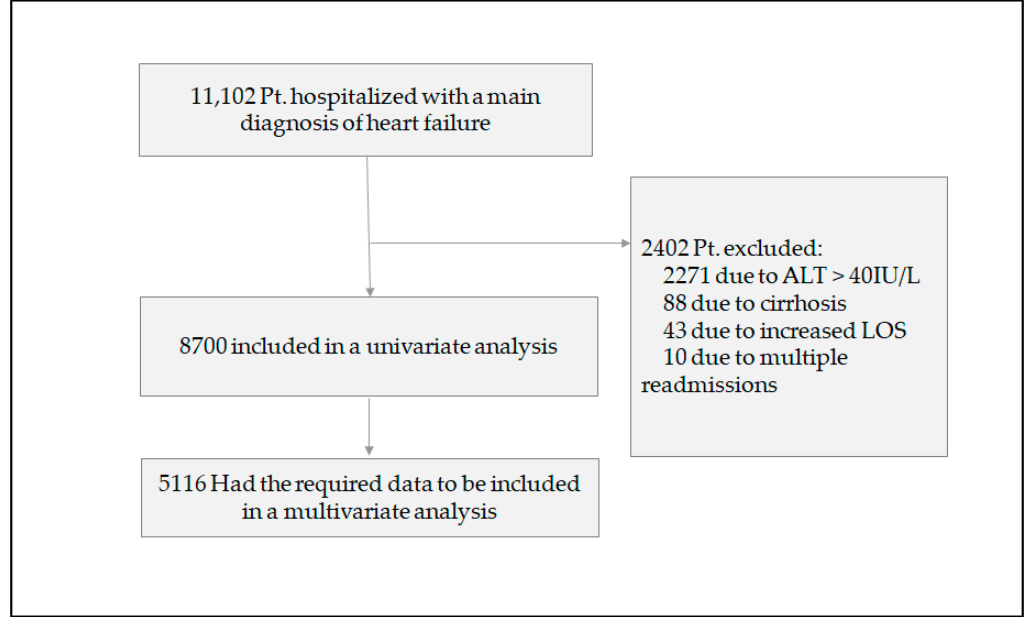
= length of (hospital)